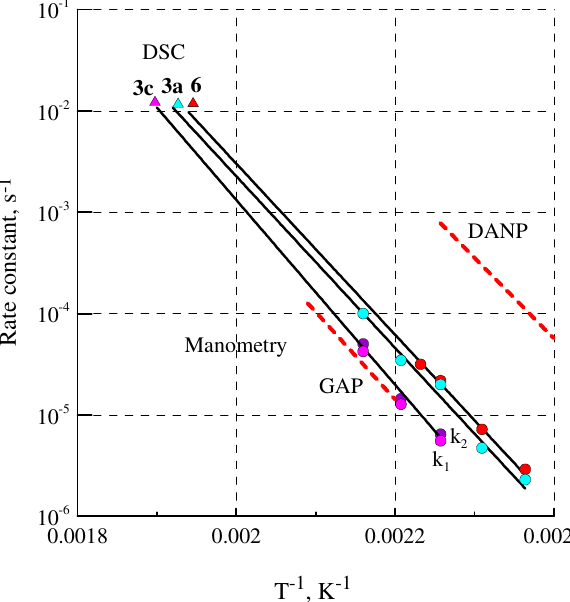
Figure 4. Comparison of decomposition rate constants 6 , 3a and 3c , under isothermal (Manometry, points and lines) and non-isothermal (DSC, triangles) conditions. Dashed lines are decomposition kinetics of GAP [56] and 1,3-diazido-2-nitro-2-azapropane (DANP) [52].